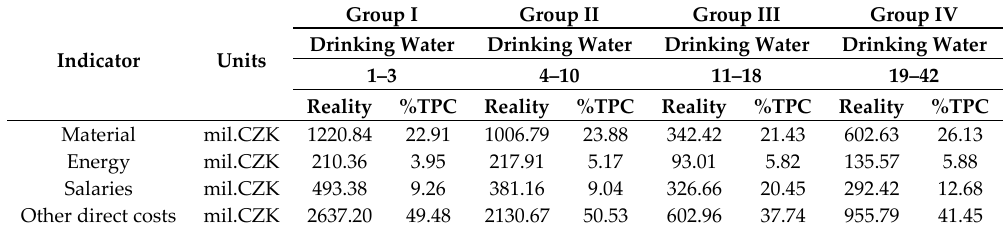
Table 1. Sample of realized costs for 2014—basis for approval of water price